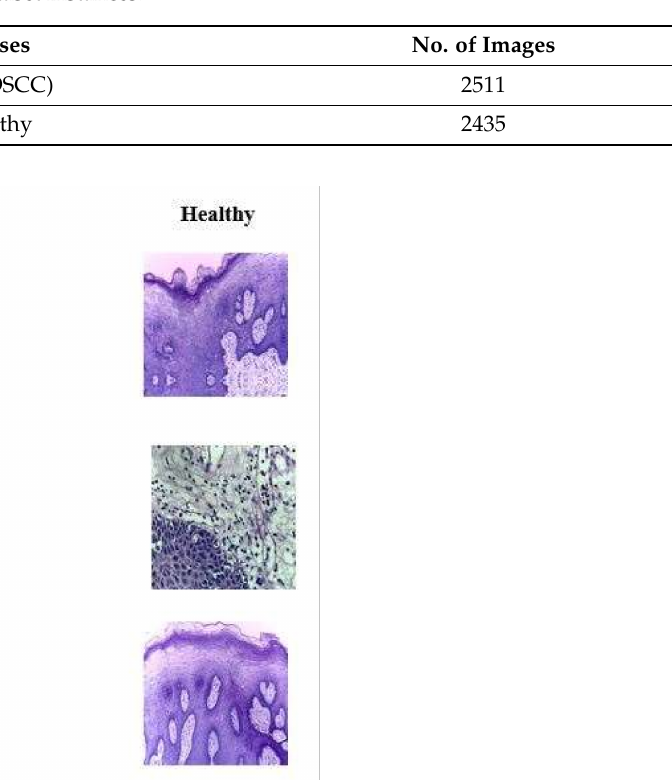
Table 3. OSCC biopsy dataset instances.